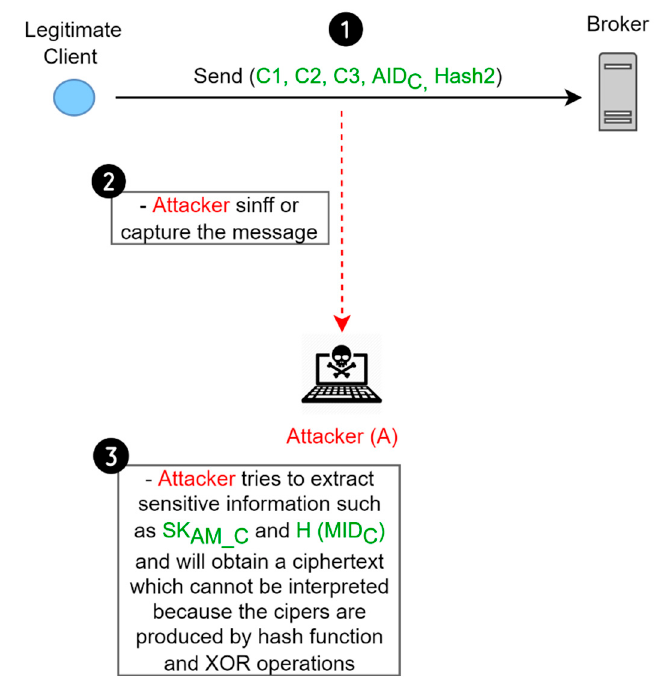
Figure 11. Eavesdropping